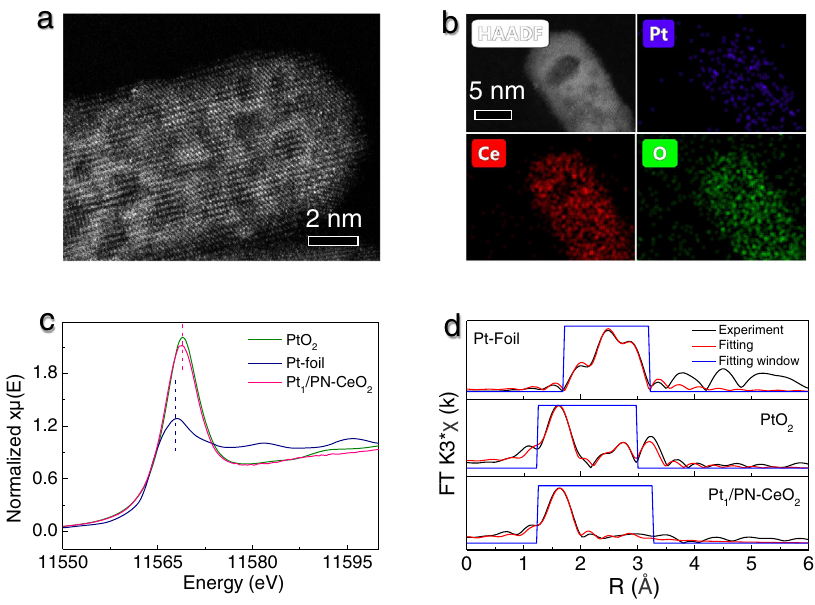
Fig. 2 | CharacterizationsofthePt 1 /PN-CeO 2 catalyst.a HAADF-STEMimageand b EDS mapping. c XANES spectra of Pt-foil, PtO 2 , and Pt 1 /PN-CeO 2 . d The k 3 -